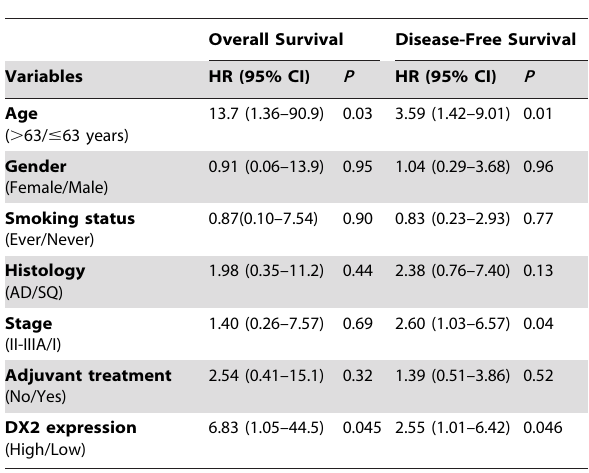
Table 1. Multivariate analysis for overall and disease-free survival by demographics, smoking status, histological type, and pathologic